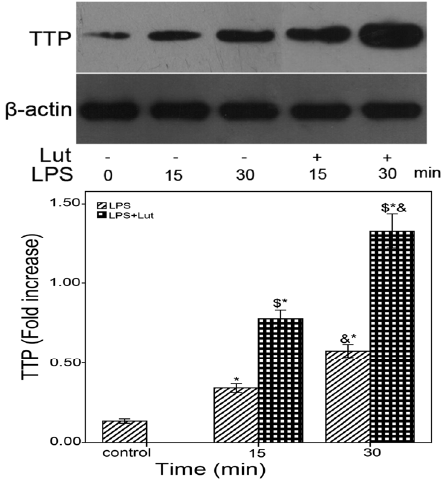
Figure 5. Lut affects TTP expression BMM were pretreated with Lut (50 μ M) or DMSO for 90 min, after incubated with or without LPS (1 μ g/mL) for the indicated times. The cell lysates were analyzed by the western blot method with antibodies TTP. * p < 0.01 vs. control, & p < 0.01 vs. 15 min, $ p < 0.01 as (LPS + Lut group) vs. (LPS group).